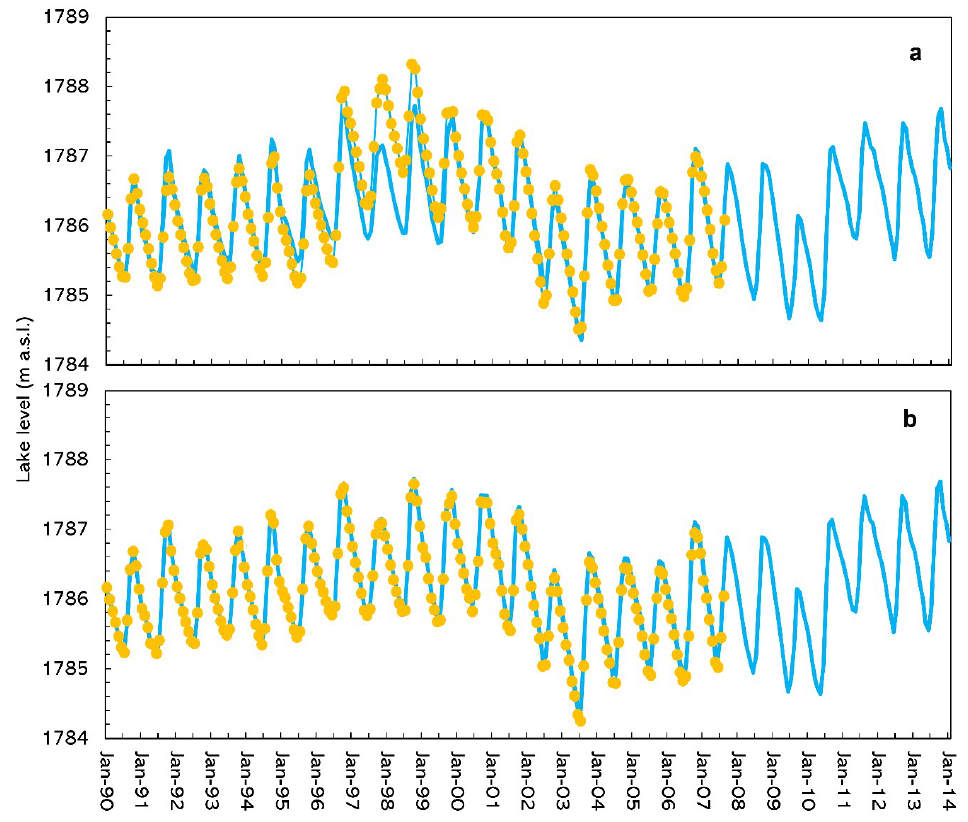
Figure 11. Water-level predictions (yellow dots) for Lake Tana for an evaporation rate of 1650 mm a − 1 ; ( a ) rainfall based on land-based rainfall stations; ( b ) rainfall partly based on the lake and the land + lake-based rainfall stations. The blue line is the observed lake water